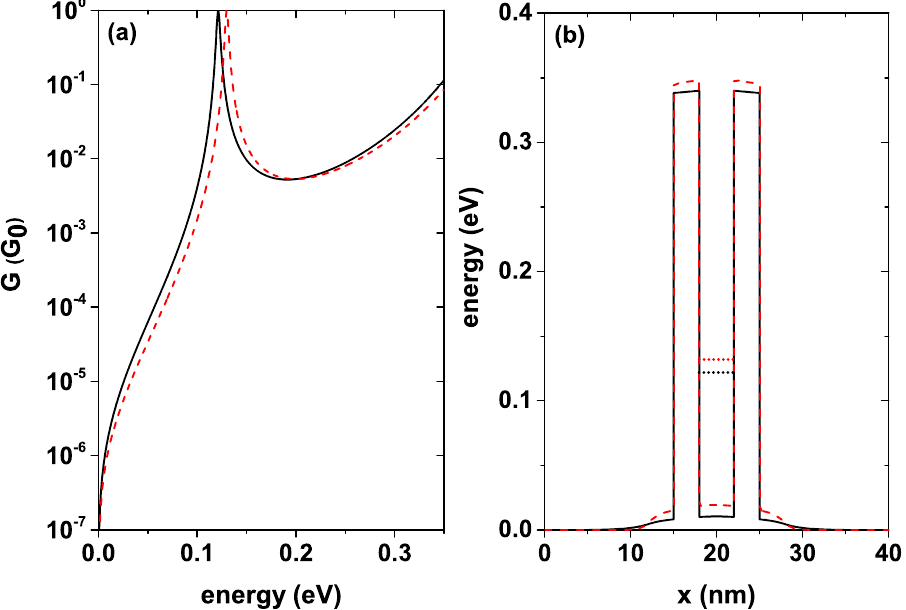
Figure 8. ( a ) Conductance for L w = 4nm, for two different donor concentrations in units of G 0 = e 2 / π ¯ h 2 , solid black line n d = 1.2 × 10 18 [1/cm 3 ], and dashed red line n d = 10 × 10 18 [1/cm 3 ]. ( b ) Corresponding self-consistent potentials. The curves were calculated at T =